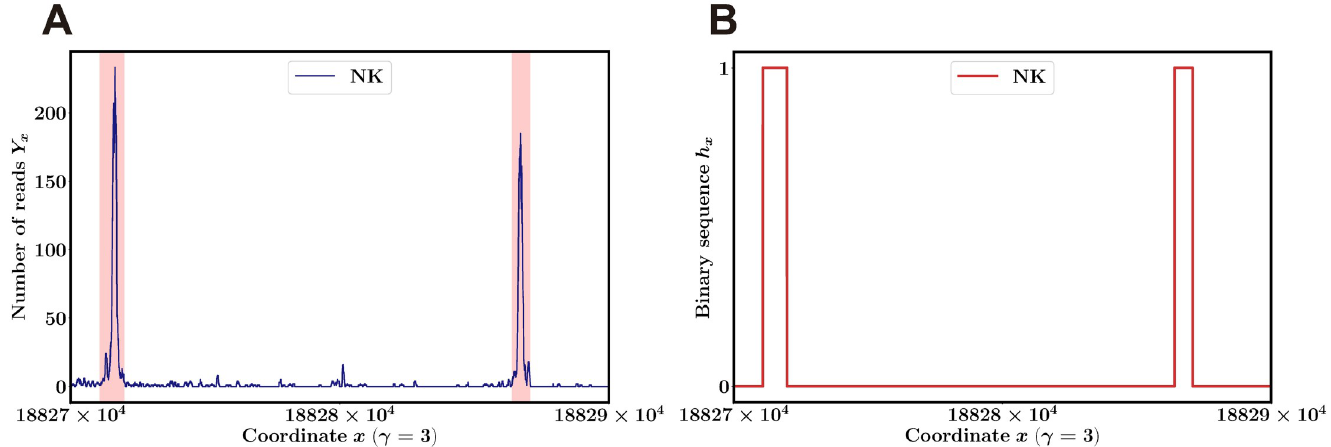
Fig 4. Binarizing the number of reads. (A) The number of reads Y x at each position x along chr 3 ( γ = 3) and the peak region ( α k , β k ) as determined by the MACS2 algorithm with peak calling parameter p = 10 − 2 (pink shaded regions). This figure shows representative data of NK cells obtained from SRA with accession number G SRR2920495. The peak regions and the associated p -values (( α k , β k ), p k ) in the left and right peaks are ((188271079, 188271985), 10 − 422.5872 ) and ((188286401, 188287077), 10 − 329.52139 ), respectively. Thus, the width of the peaks ( β ) in the left- and right-hand sides are 906 and 676, respectively. (B) Binary sequence ( h k − α k determined by the peak regions seen in (A) when we chose M cut satisfying p � 10 (cid:0) 329 : 52139 M cut